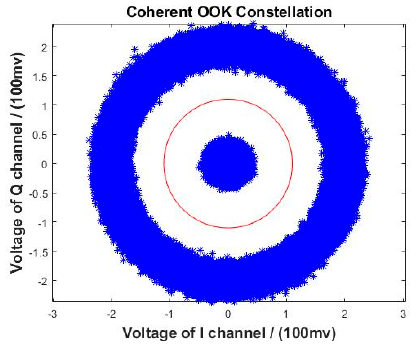
Figure 4. Constellation of OOK for coherent reception (simulated SNR: 20 dB).